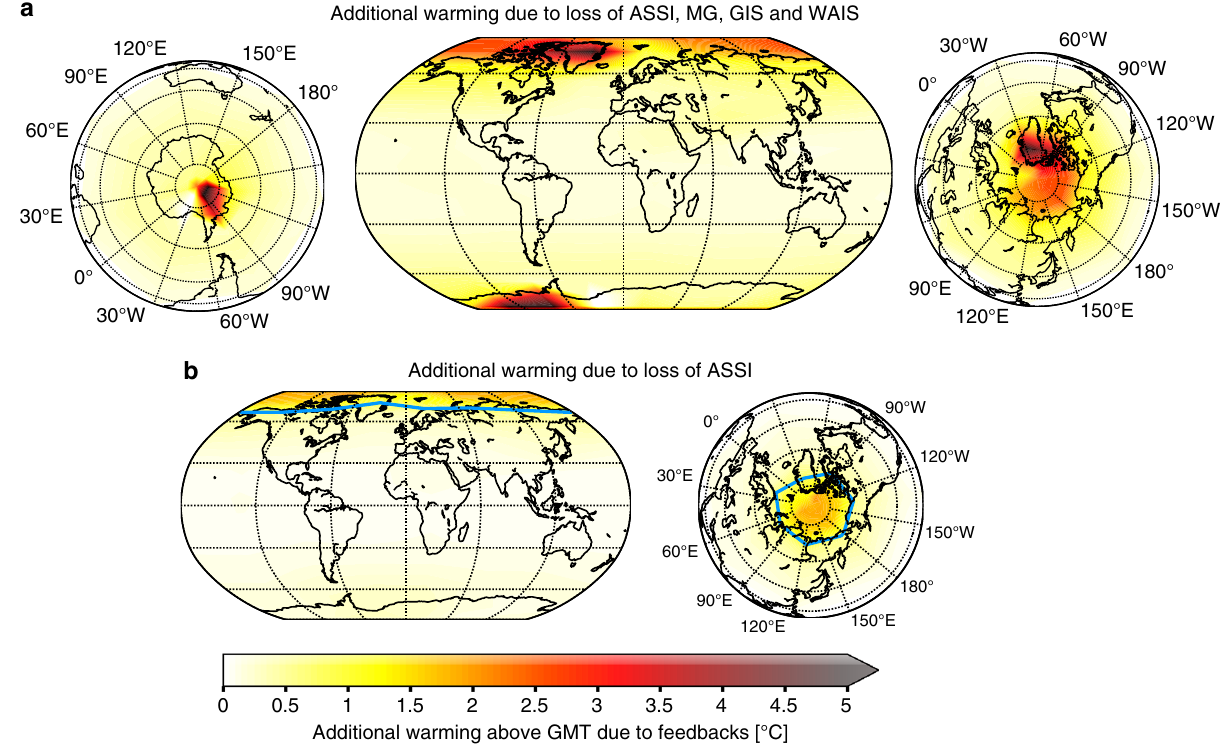
Fig. 1 Regional warming due to feedbacks. a Regional warming for the whole Earth if Arctic summer sea ice (ASSI) in June, July and August, mountain glaciers (MG), Greenland Ice Sheet (GIS) and West Antarctic Ice Sheet (WAIS) vanish at a global mean temperature of 1.5 °C above pre-industrial. b Same as in ( a ) with an additional zoom-in of the Arctic region if only the Arctic summer sea ice vanishes, which might happen until the end of the century. The light blue line indicates the region of removed Arctic summer sea ice extent, where its concentration in CLIMBER-2 is 15% or higher. In all panels, the average additional warming on top of 1.5 °C is shown in absolute